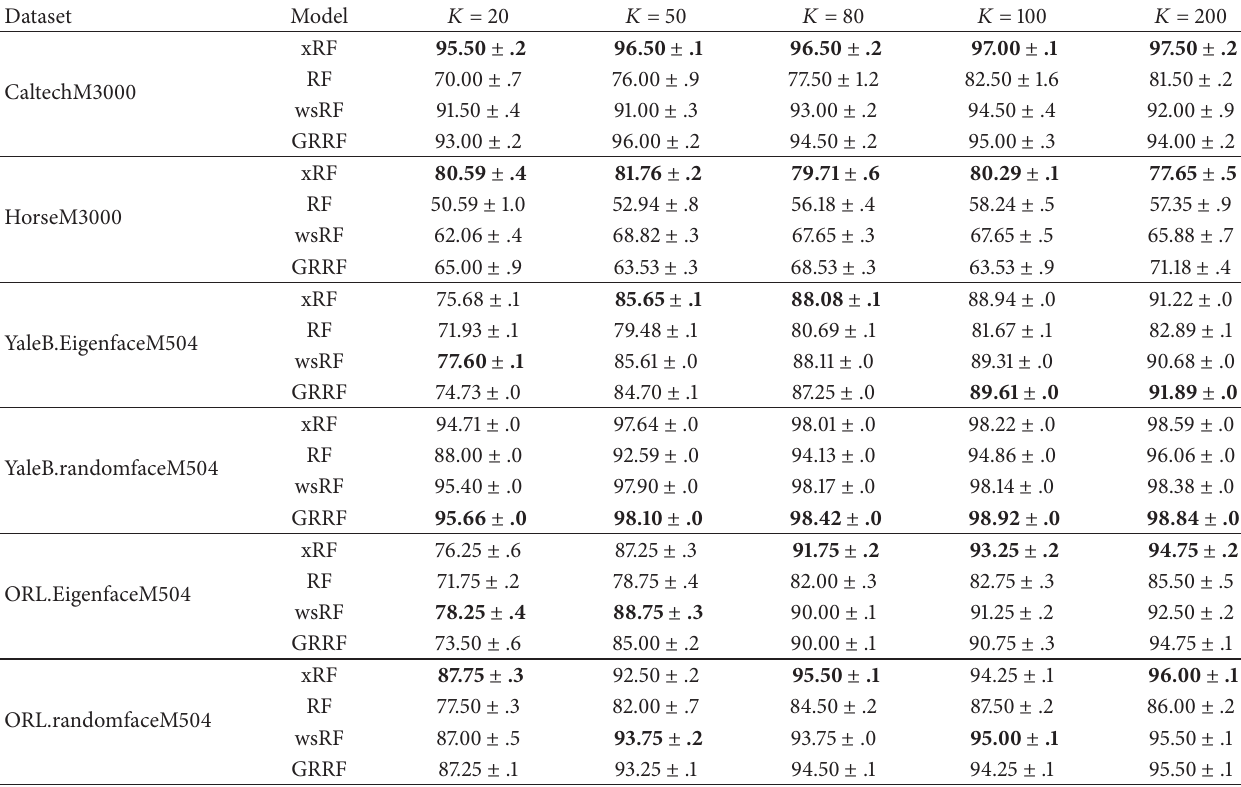
Table 3: The prediction test accuracy (mean% ± std-dev%) of the models on the image datasets against the number of trees 𝐾 . The number of feature dimensions in each subdataset is fixed. Numbers in bold are the best results.